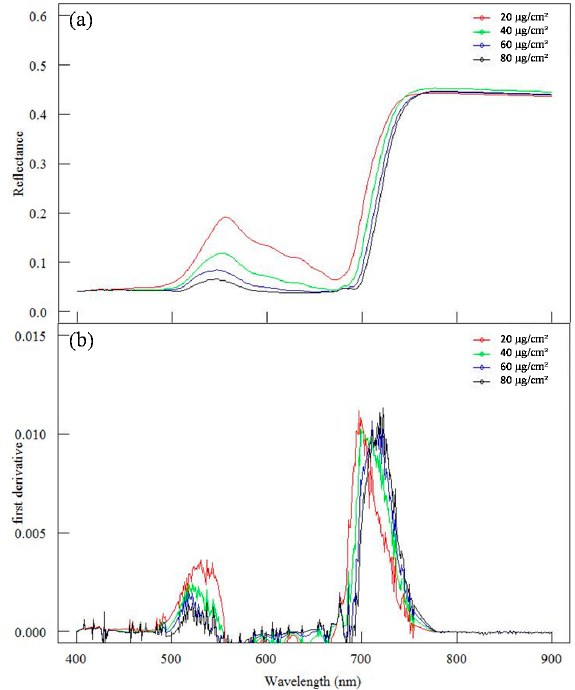
Figure 12. ( a ) Mean reflectance spectra and ( b ) first-order derivative spectra simulated by PROpriétés SPECTrales Version 5 (PROSPECT 5).